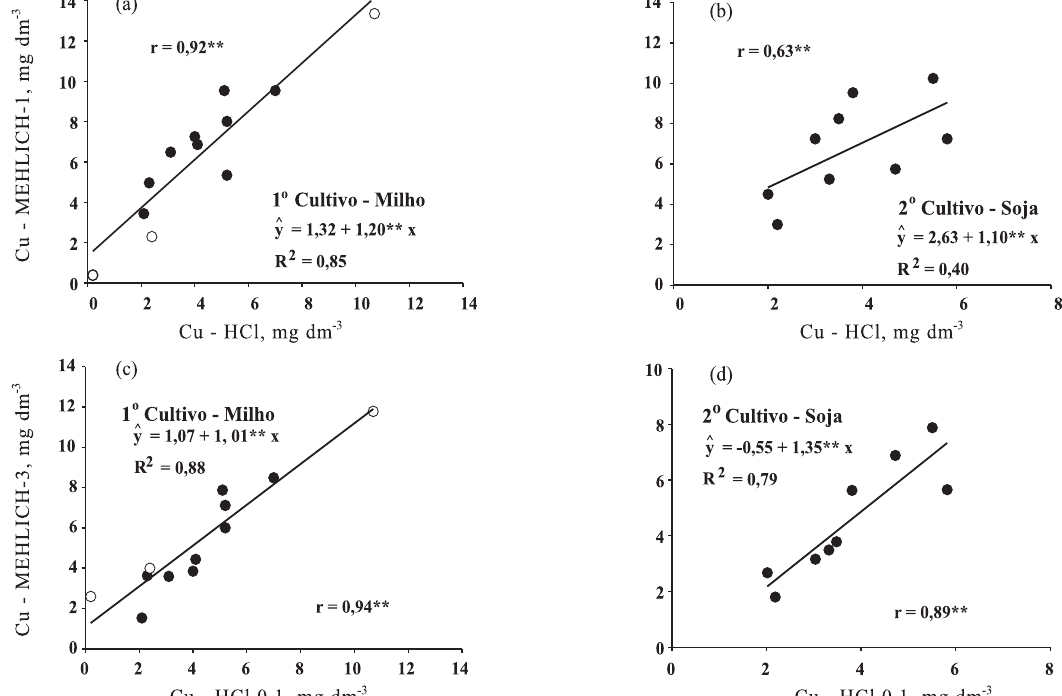
Figura 1. Relação entre os teores de cobre extraídos pelas soluções de HCl, Mehlich-1 e Mehlich-3, respectivamente, em amostras de solos coletadas antes do primeiro [(a) e (c)], com milho, e segundo cultivos [(b) e (d)], com